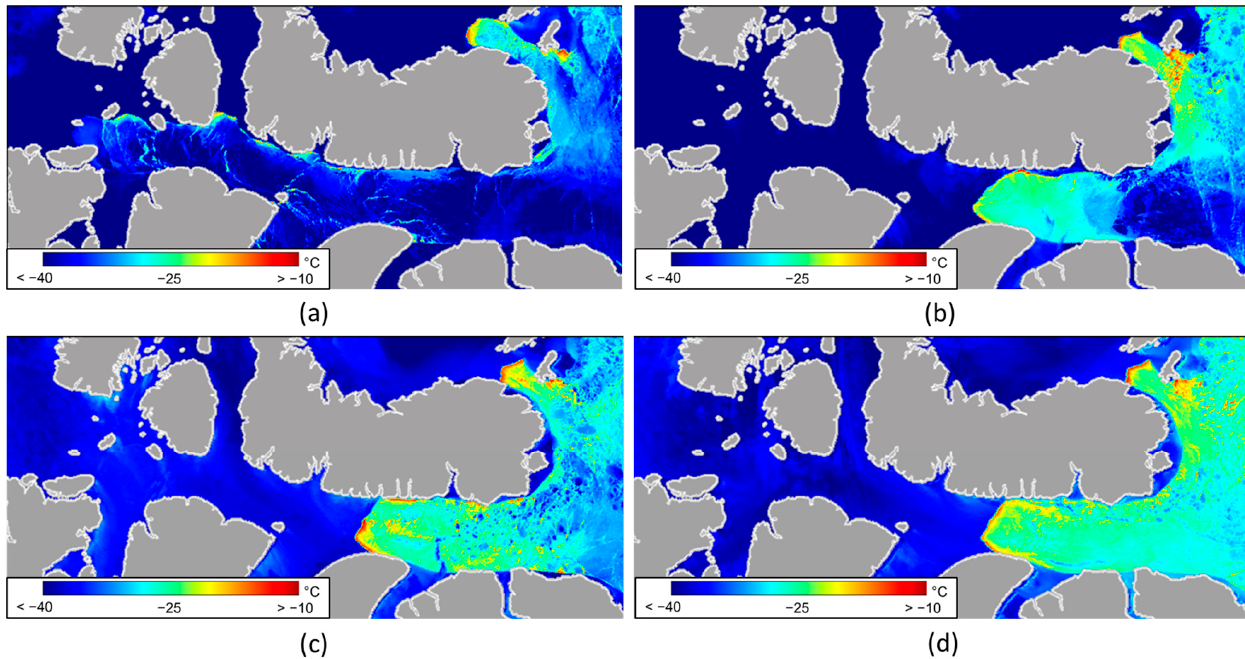
Figure 9. CASSTA mapping with land mask for 2019, including ( a ) 14 January, ( b ) 17 February, ( c ) 24 March and ( d ) 14 April. Lancaster Sound appears close to freezing solid in January, but a month later the ice arch is established and provides an excellent thermal contrast to the solid ice to the west. Once the ice arch forms, the surface temperatures are significantly warmer in the polynya than the surrounding ice pack.